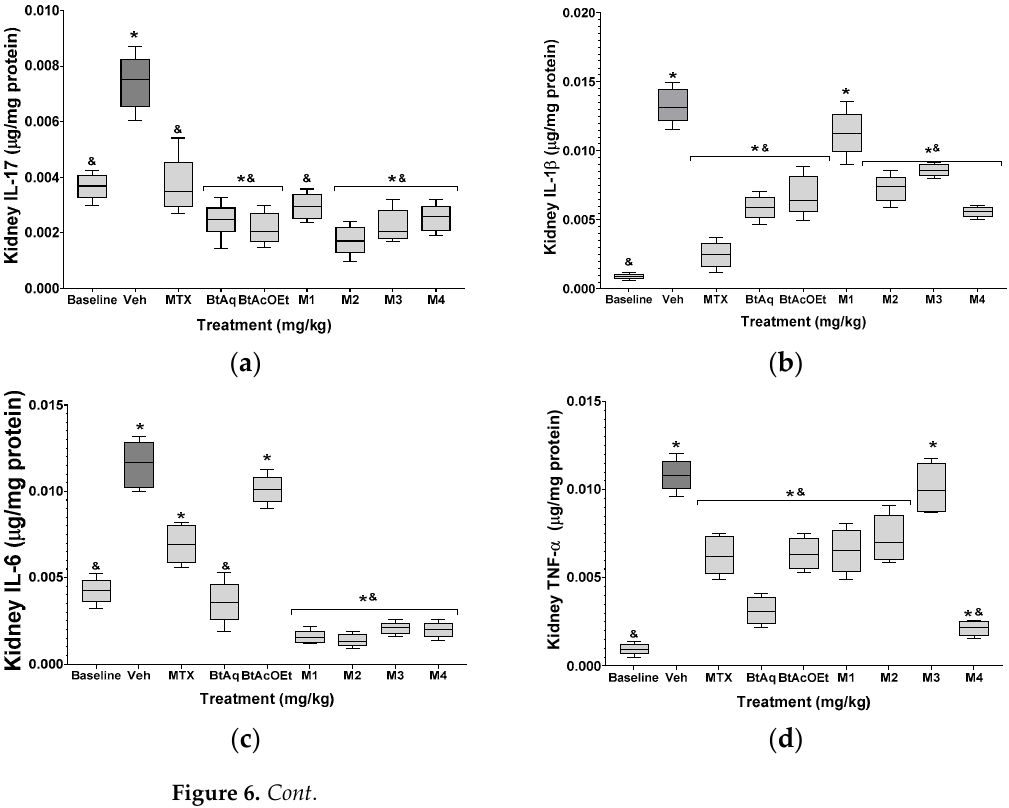
( e ) Figure 6. Effect of different treatments obtained from the B. ternifolia root extract on the inflamma- tory response ( a ) IL-17, ( b ) IL-1 β , ( c ) IL-6, ( d ) TNF- α and ( e ) IL-10 of the kidneys of mice with ex- perimental arthritis. The aqueous extract BtAq and the ethyl acetate extract BtAcOEt were derived from the bipartition of the complete extract. Fractions M1, M2, M3, and M4 were obtained from BtAcOEt. ANOVA with post hoc Tukey test, with * p < 0.05 compared with baseline group, & p < 0.05 compared with Veh group ( n = 7 ± SD). 2.5. Effect of Fractions and Compounds from B. ternifolia on the Expression of NF- κ B In Vitro RA leads to inflammation of the joints’ synovial membrane, with progressive de- struction of the articular cartilage and underlying bone. These structural alterations are accompanied by pain and functional limitation. The inflammatory process is mainly me- diated by the production of cytokines, growth factors, chemokines, and synovial cells. This study was conducted to evaluate different anti-inflammatory and immunomodula- tory treatments of B. ternifolia in an experimental RA assay induced with Freund’s adju- vant and to determine whether the isolated compounds inhibited the expression of NF- κ B as part of the mode of action [13]. The chemical profile of B. ternifolia was characterized by secondary metabolites, in- cluding terpenes, phenolic compounds, and cyclopeptides. This paper describes two new compounds: ternifoliol and ternifolial. These were isolated from subfractions BM4 and BM6; ternifoliol showed inhibitory activity of NF- κ B (Figure 7).